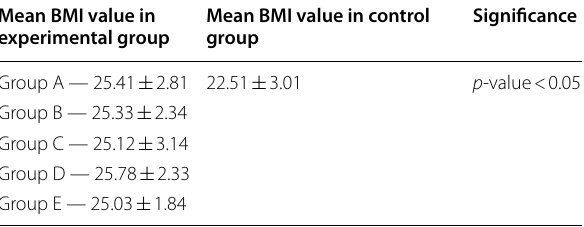
Table 4 Mean BMI value in each